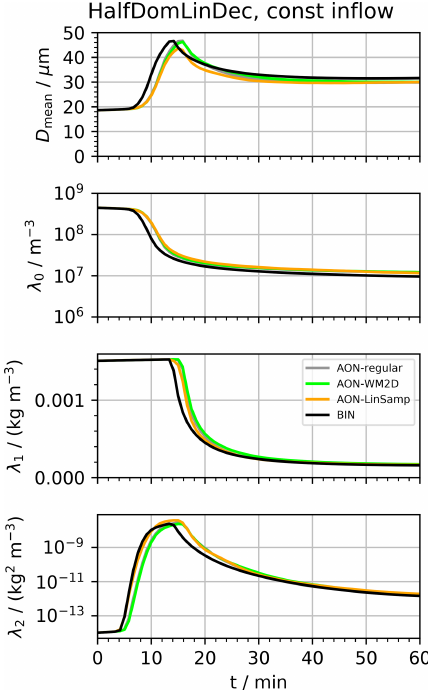
Figure 9. HalfDomLinDec set-up: temporal evolution of D mean and column-averaged moments λ 0 ,λ 1 and λ 2 for various model ver- sions (see inserted legend; “LS” is short for linear